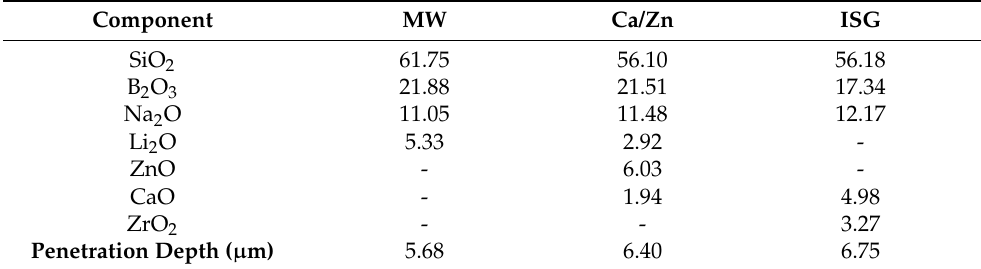
Table 1. Three glass compositions, in wt%, of relevance to the nuclear industry were exposed to a 14 MeV ion beam. Vitreous silica was also used. The penetration depth of the ion beam, as calculated by SRIM-2013 [38], and used in the step height calculations, is also provided. Component MW Ca/Zn ISG SiO